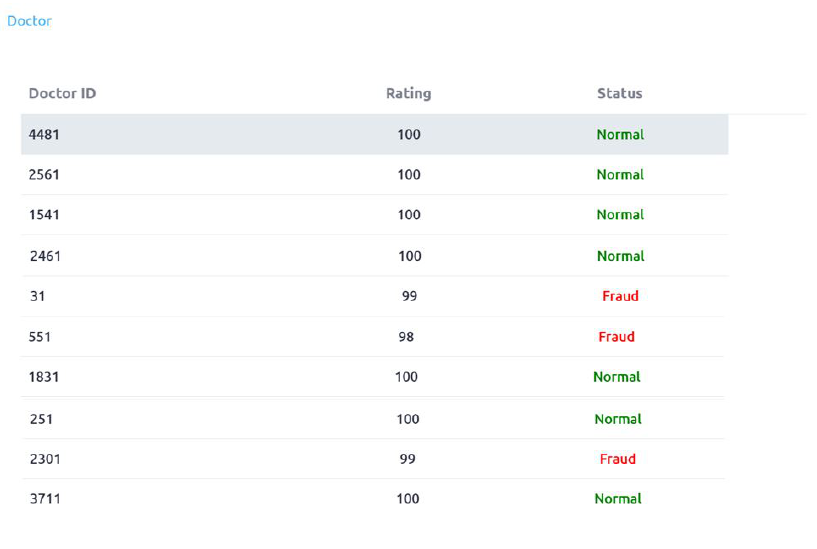
Figure 14. Doctors rating and status.